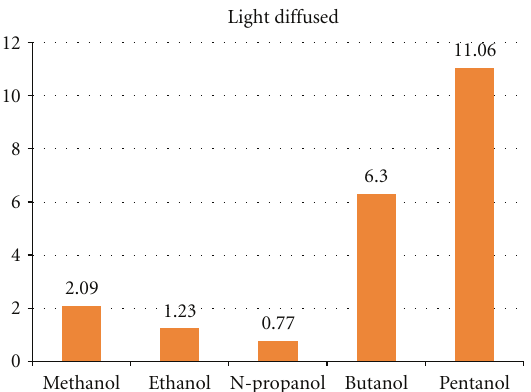
Figure 3: Percentage of light di ff